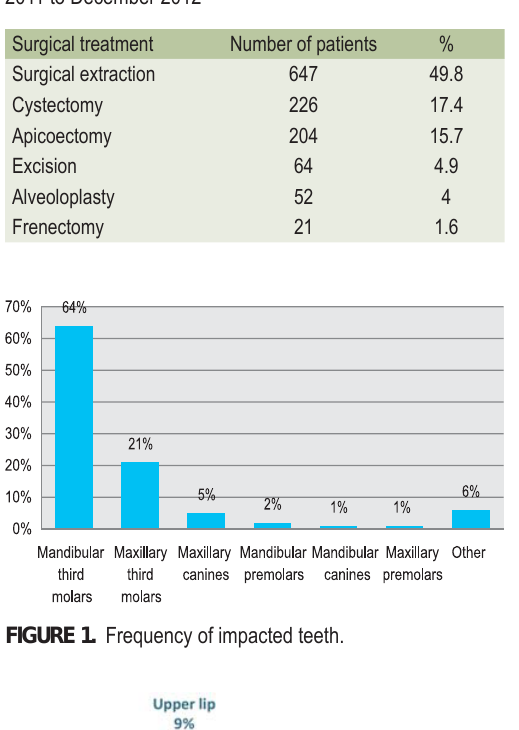
TABLE 2. Surgical treatments performed at Department of Oral Surgery, Faculty of Dentistry Sarajevo, from January 2011 to December 2012